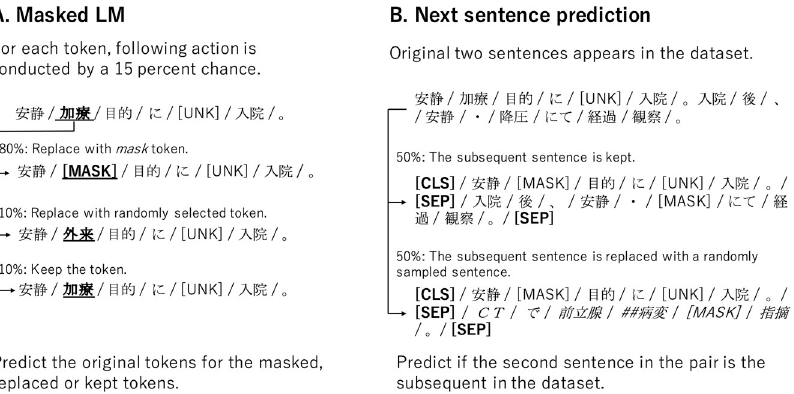
Fig 2. The schematic view of Masked-LM and Next Sentence Prediction task. A. Masked LM predicts the original tokens for the masked, replaced or kept tokens. B. Next Sentence Prediction predicts if the second sentence in the pair is the subsequent sentence in the original documents. The role of special symbols are as follows: [CLS] is added in front of every input text, and the output vector is used for Next Sentence Prediction task; [MASK] is masked token in Masked-LM task; [SEP] is a break between sentences; [UNK] is unknown token that does not appear in the vocabulary.